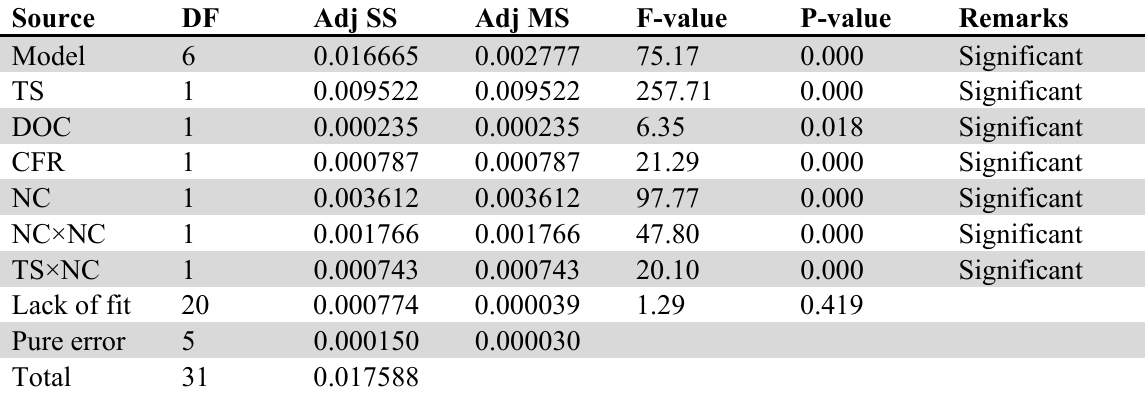
ANOVA table of surface roughness of soft EN31 steel